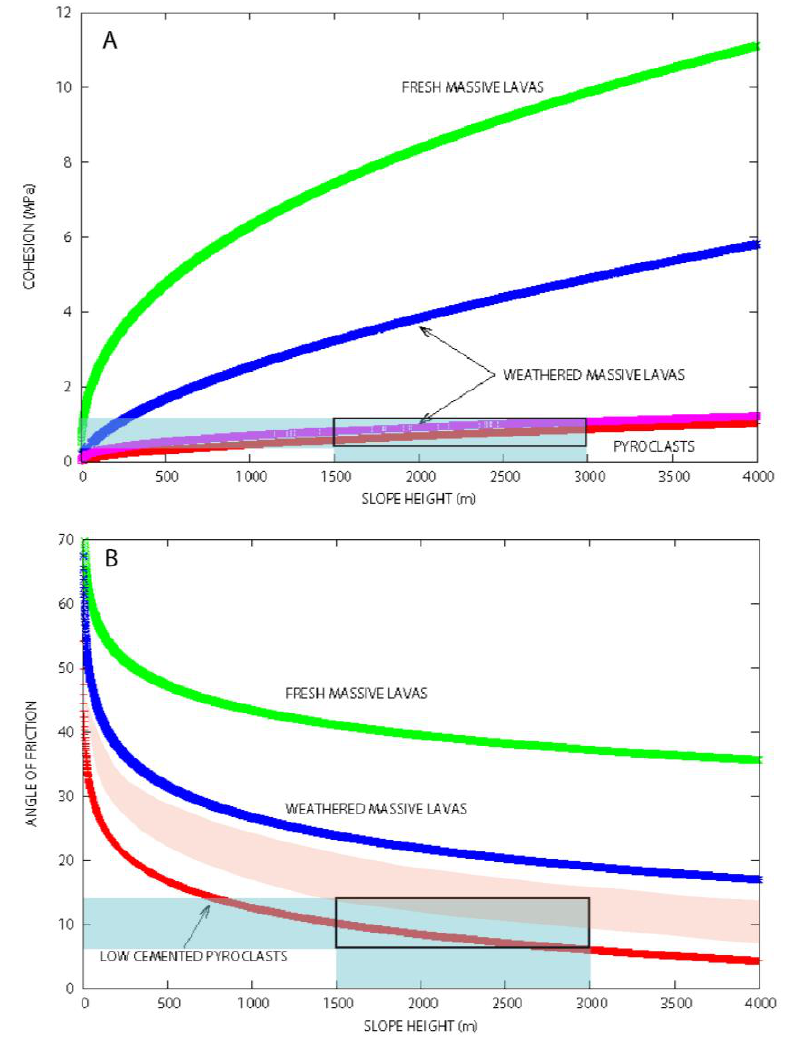
Figure 3. Effect of depth on mechanical properties. ( A ) Cohesion for low cemented pyroclasts ( k = 0.05; l = 0.5) and fresh ( k = 0.37; l = 0.60) and weathered ( k = 0.04; l = 0.41 and 0.60) massive lavas, ( B ) Angle of friction for low cemented pyroclasts ( a = 6; b = 54) and fresh ( a = 5.6; b = 82) and weathered ( a = 7; b = 75) massive lavas.